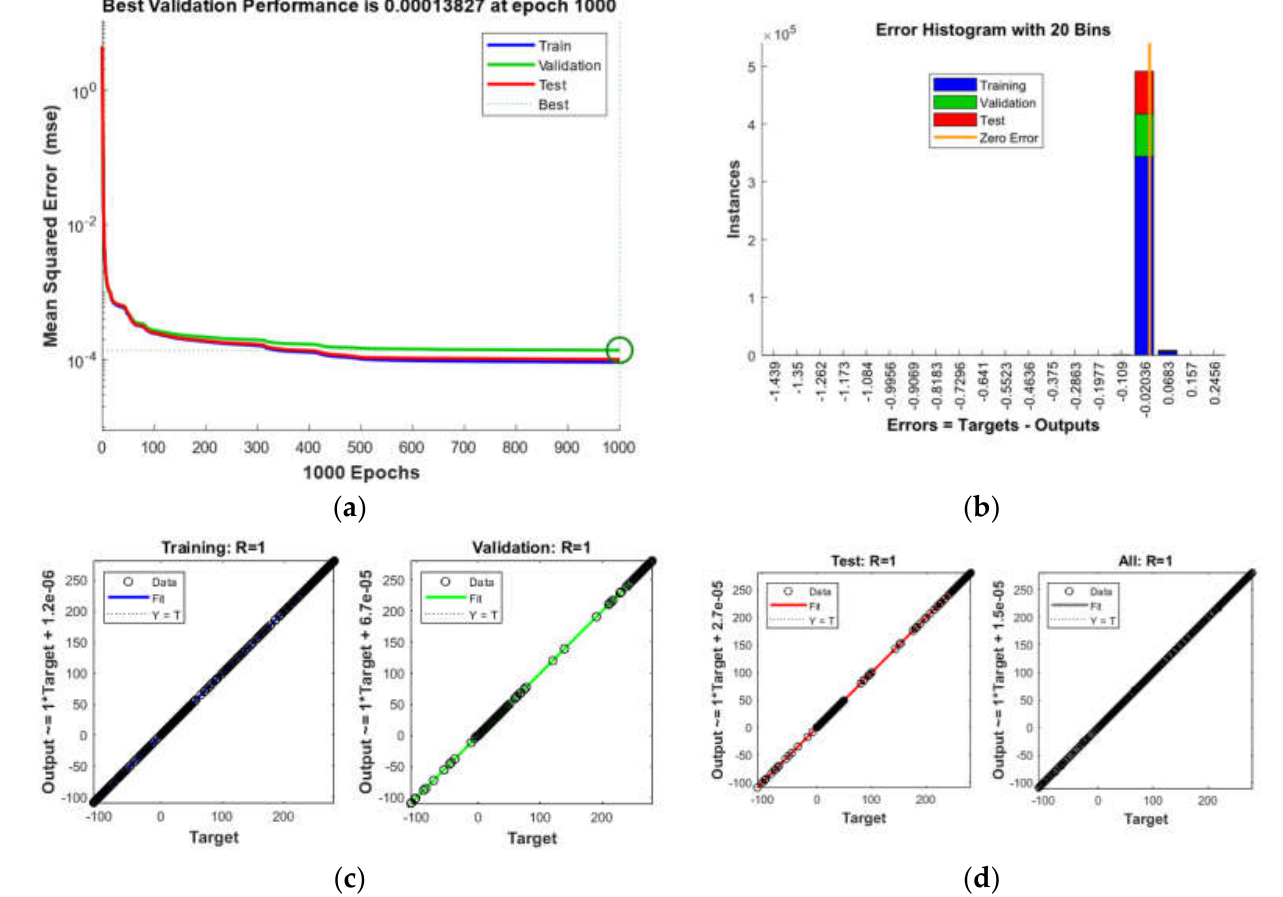
Figure 17. ( a ) Performance of the narx-based rotor speed estimator considering mean squared error (MSE); ( b ) Error histogram of the narx-based rotor speed; ( c ) Regression between the rotor speed estimated by the narx and then measured in the IM drive during training and validation; ( d ) regres- sion during testing and regression globally calculated of the speed estimator.